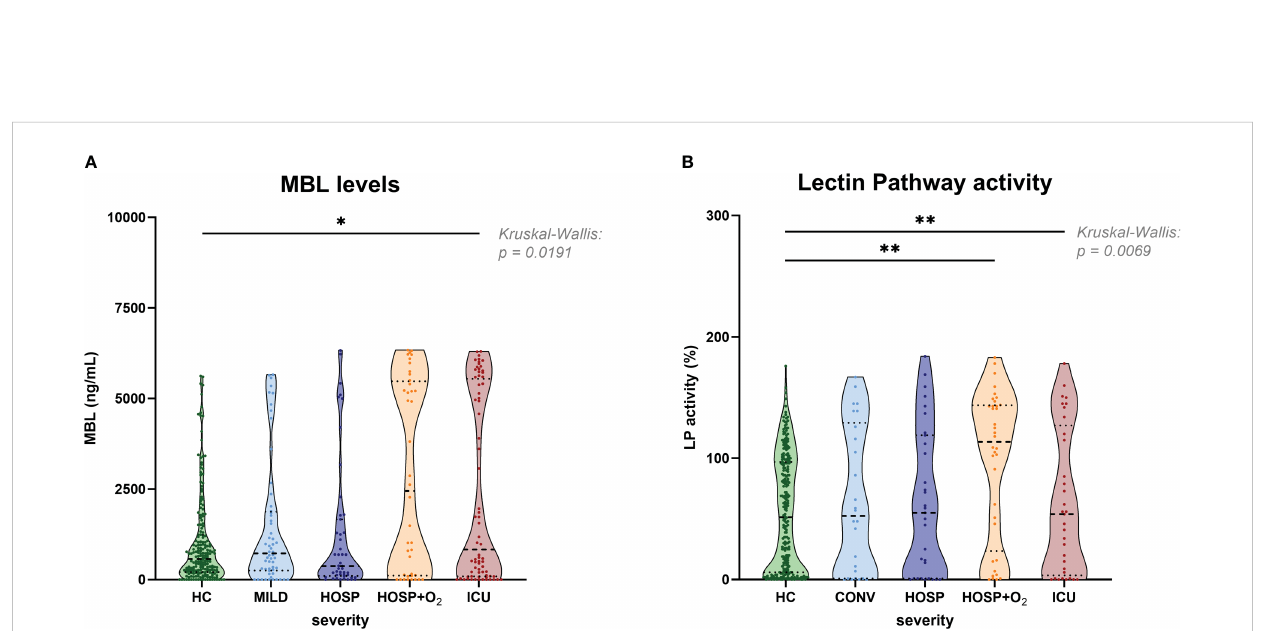
FIGURE 5 MBL levels (CAM) and Lectin pathway activity (BUD) in healthy controls and COVID-19 patients, strati fi ed according to disease severity. (A) MBL levels measured in the Cambridge COVID-19 cohort and healthy individuals and (B) Lectin pathway activity measured in the Hungarian COVID-19 cohort and healthy controls strati fi ed according to disease severity. Differences between severity groups were determined using Kruskal-Wallis test with Dunn ’ s multiple comparison post-hoc test. Non-signi fi cant differences are not marked, and asterisks indicate signi fi cant results (* p<0.05, ** p<0.01). HC, Healthy controls; MILD, patients not requiring hospitalization; CONV, patients not requiring hospitalization and sampled during convalescence; HOSP, Hospitalized patients not requiring ventilation; HOSP+O 2 , Hospitalized patients requiring ventilation; ICU, Intensive care unit patients; LP, lectin pathway.